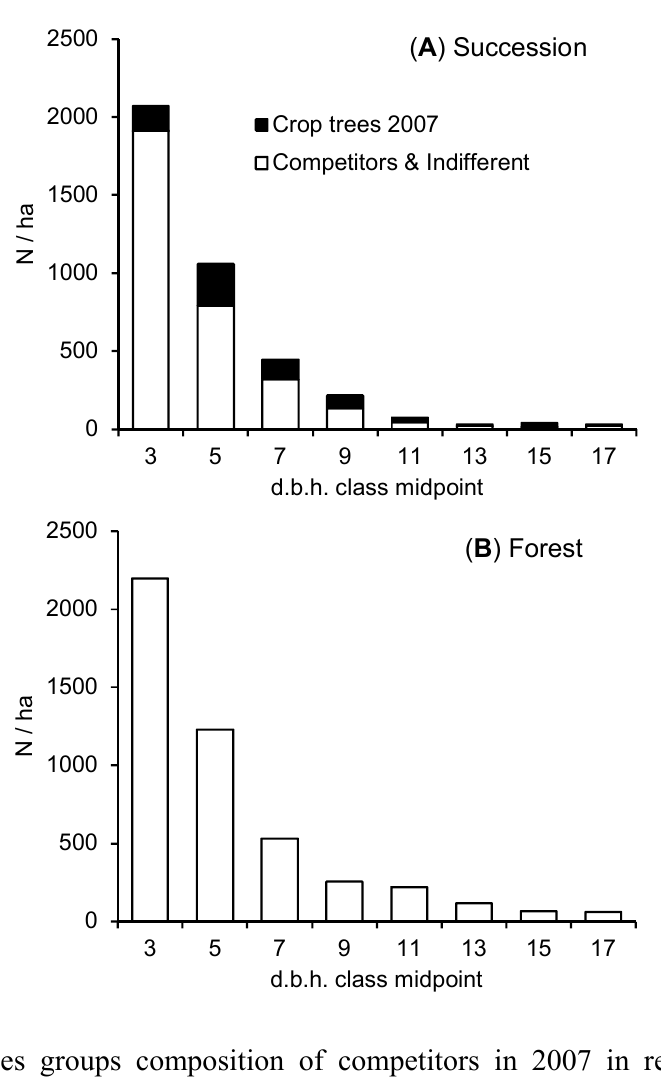
Figure A1. Comparison of the frequency distributions of trees according to d.b.h. classes in Succession ( A ) and Forest ( B ) in 2007; for Succession, the d.b.h. distribution of crop trees at the beginning of the experiment is also given.